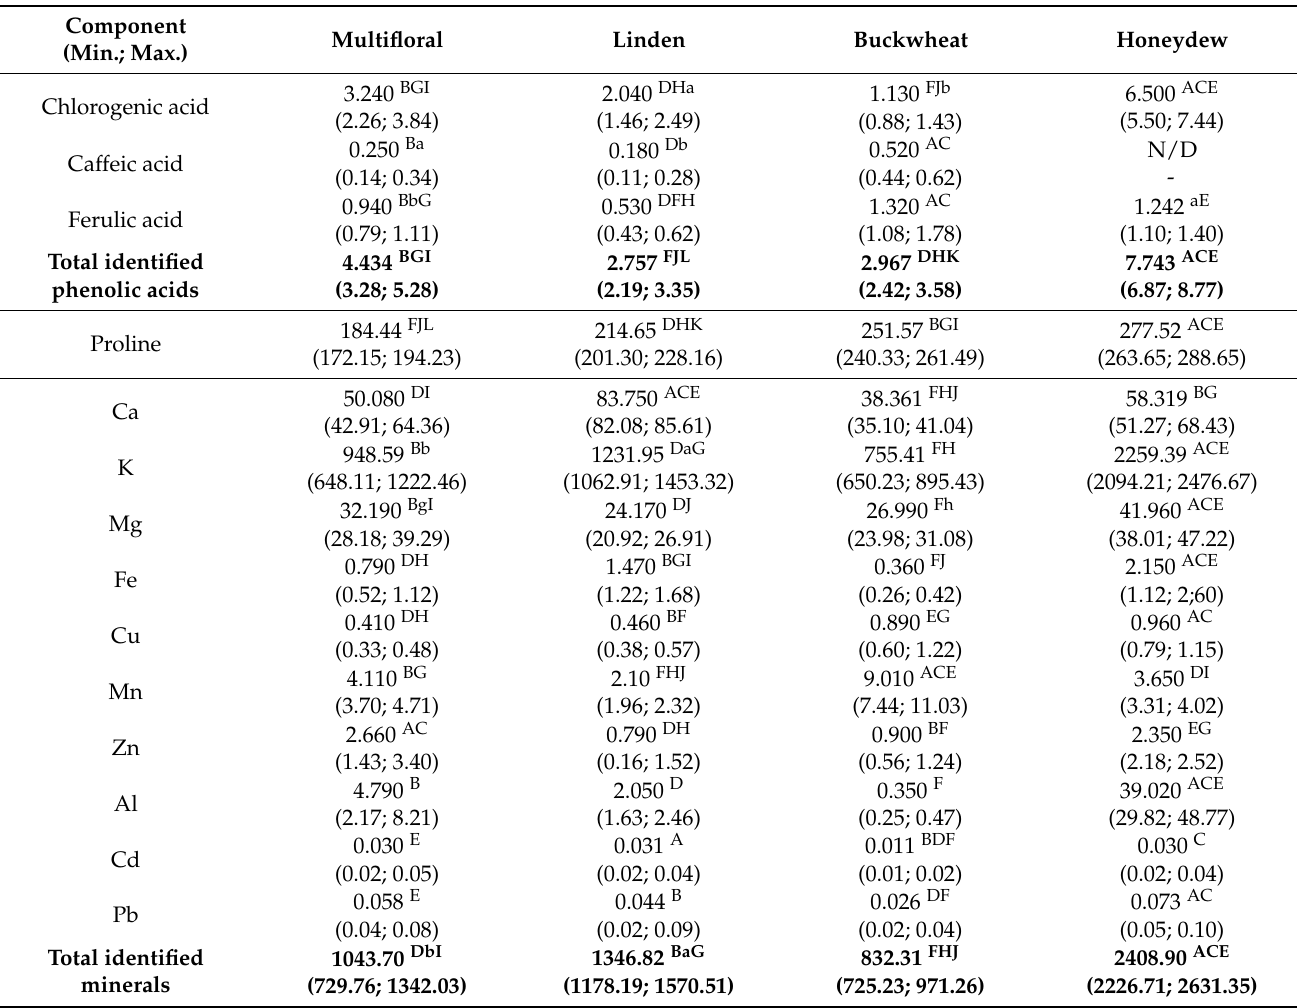
Table 1. Comparison of phenolic acids, proline, and mineral content of different types of honey (mg · kg − 1 ). Component (Min.;